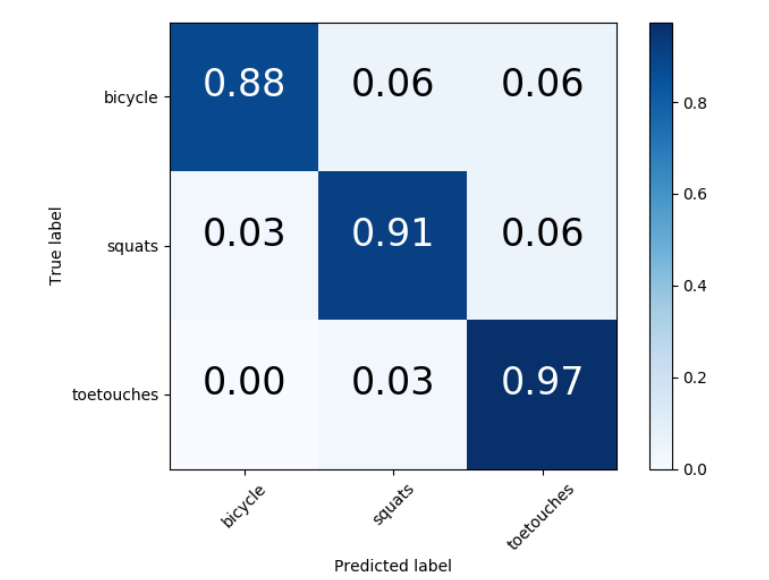
Figure 6. Confusion matrix of the convolutional neural network is